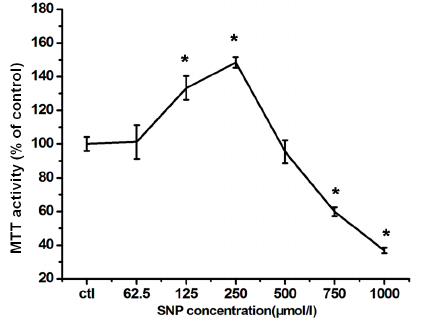
Figure 2. The neuro-effects of SNP on RGC-5 cells. Cells were exposed to different concentrations of SNP as indicated for 24 h. Cell viability was evaluated by MTT assay. The values were expressed as percentage of control, which is set to 100%. The percentage of MTT activity was presented as mean ± SD for six replicates. * p < 0.05 vs. control group.